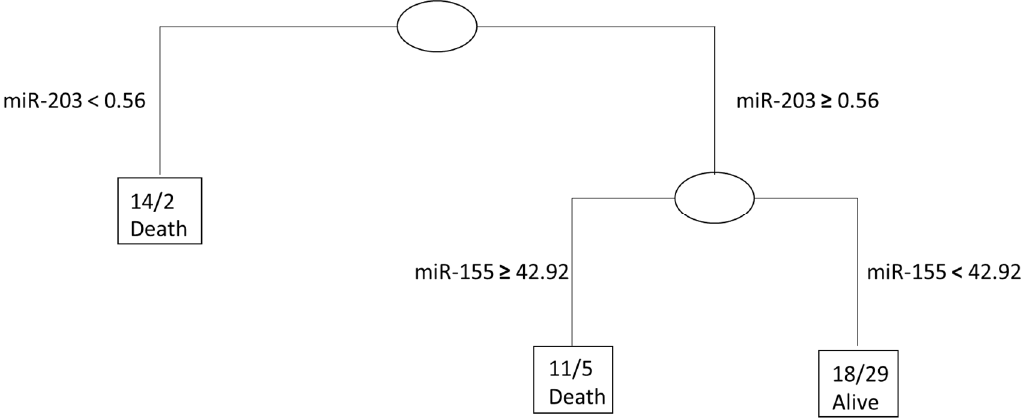
Figure 1. Classification tree establishing the influence of each microRNA in a combinational approach towards risk stratification.